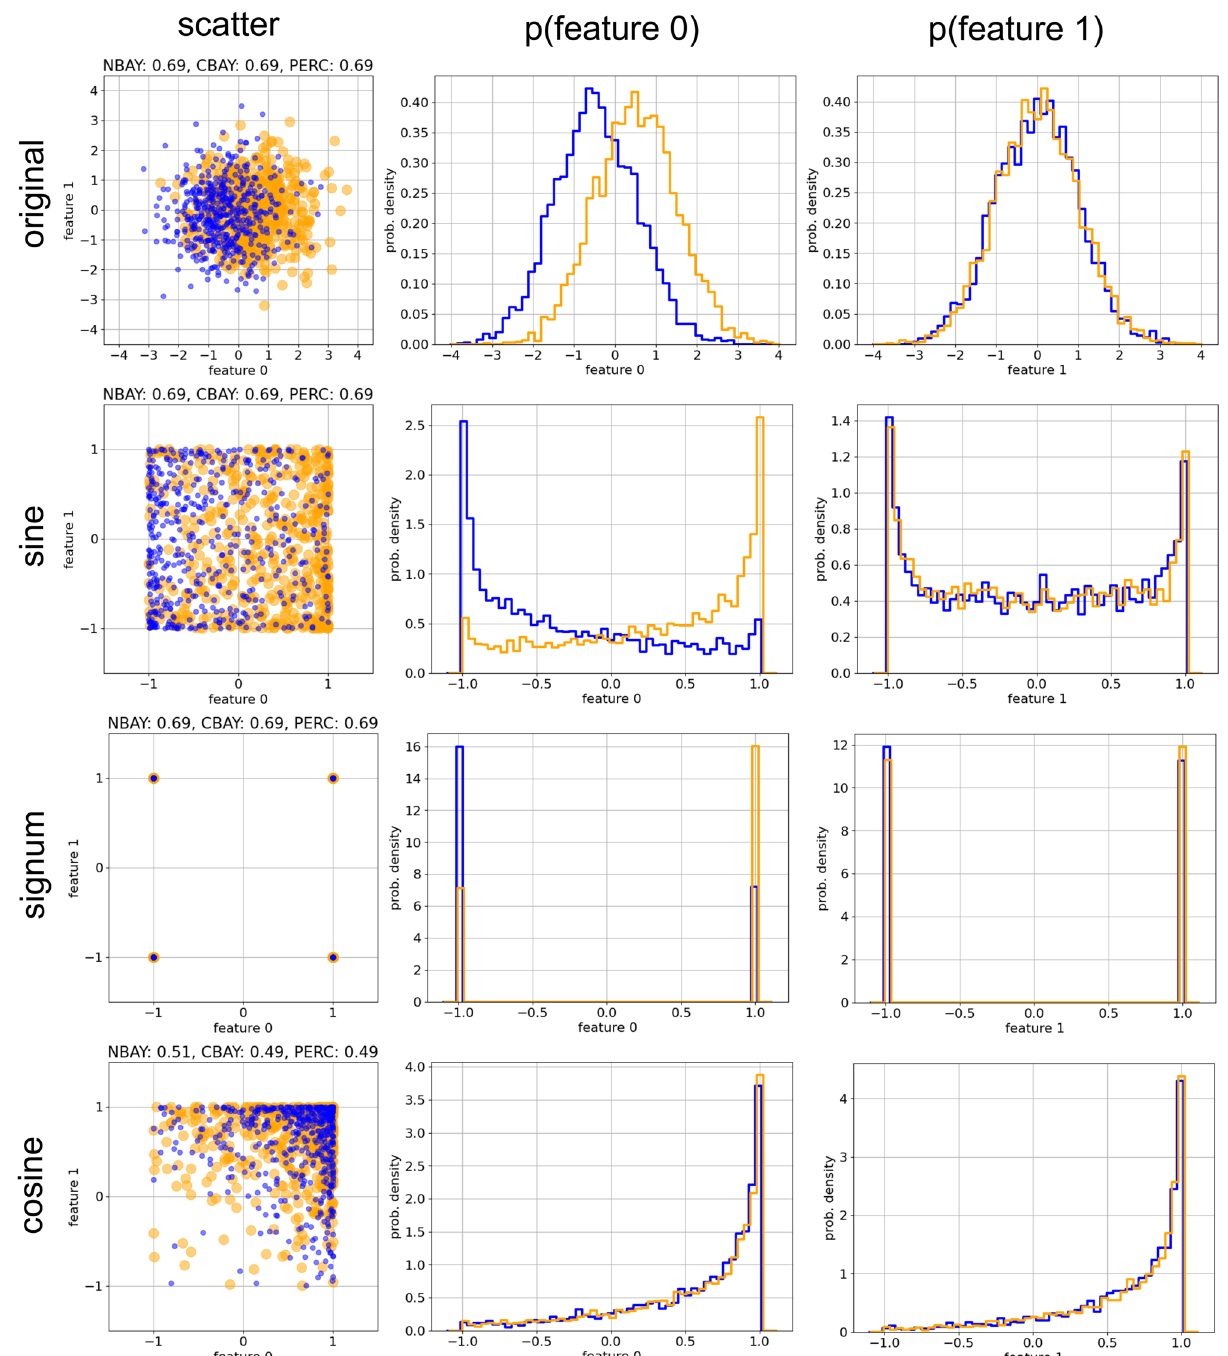
Figure 6. Effect of non-linear feature transformations on the maximal classification accuracy of the Naive Bayesian model (NBAY), the CMVG Bayesian model (CBAY) and the Perceptron (PERC). We consider two partly overlapping classes (blue and orange colors) in a two-dimensional features space. Shown are a scatter plot of the data (first column), as well as the marginal probability densities of the two features (second and third column). In the case of the orginal data (first row), all three classifier types reach the theoretical accuracy limit of ≈ 0.69 . After applying a sine-function individually to each feature (second row), the shape of the distributions changes drastically, but the accuracies remain unchanged at the theoretical limit. This remains even true after applying a signum transformation (third row), which reduces the originally continuous data to only four discrete points. However, applying a cosine transform (fourth row) reduces the accuracy to the random baseline of ≈ 0.5 , because the two data classes now overlap